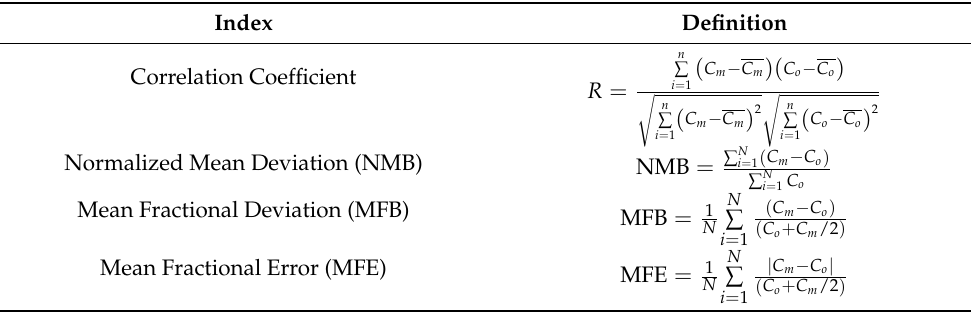
Table 3. Indices used to evaluate model